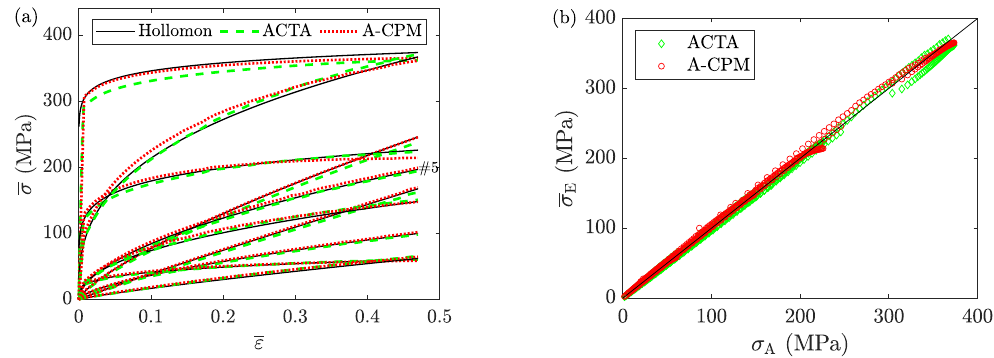
Figure 16. The stress analysis of the ten reference samples (see Table 1). ( a ) average flow curves obtained from A-CPM (Equation (4)) and ACTA (according to the algorithm developed for Case 2) in comparison with the assigned Hollomon models. ( b ) the correlation between the estimated average stresses (A-CPM and ACTA) and the assigned values. (Sample #5 is randomly selected for further detailed discussions in this section. For that, its flow curve is identified in the subset ( a